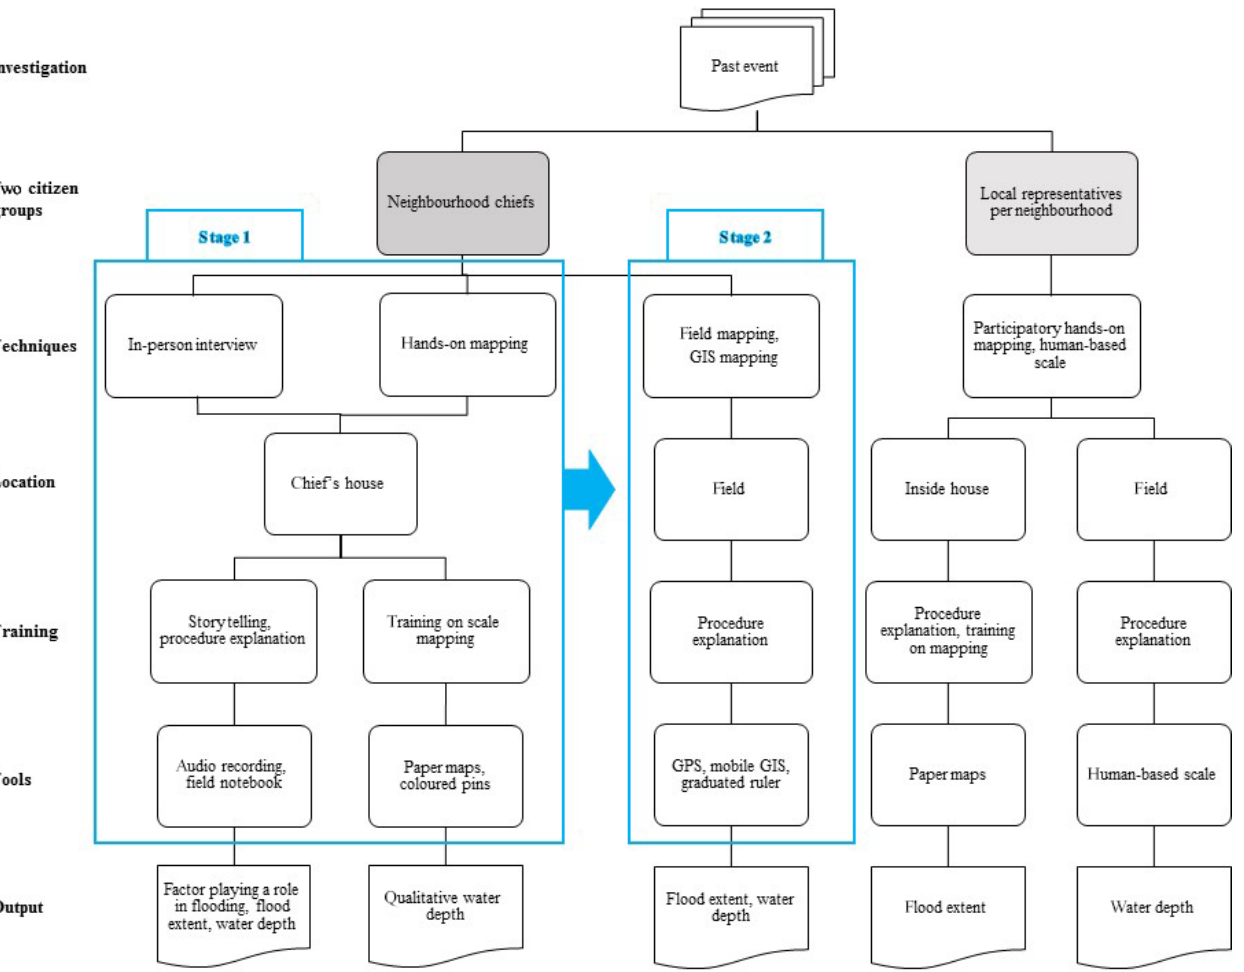
Figure 2. Framework for retrieving past flood information by citizen-based methodology. The data regarding this article are available online at: https://doi.org/10.26037/yareta:excgdpysdfadtcyffr4dclt3mm (Sy,